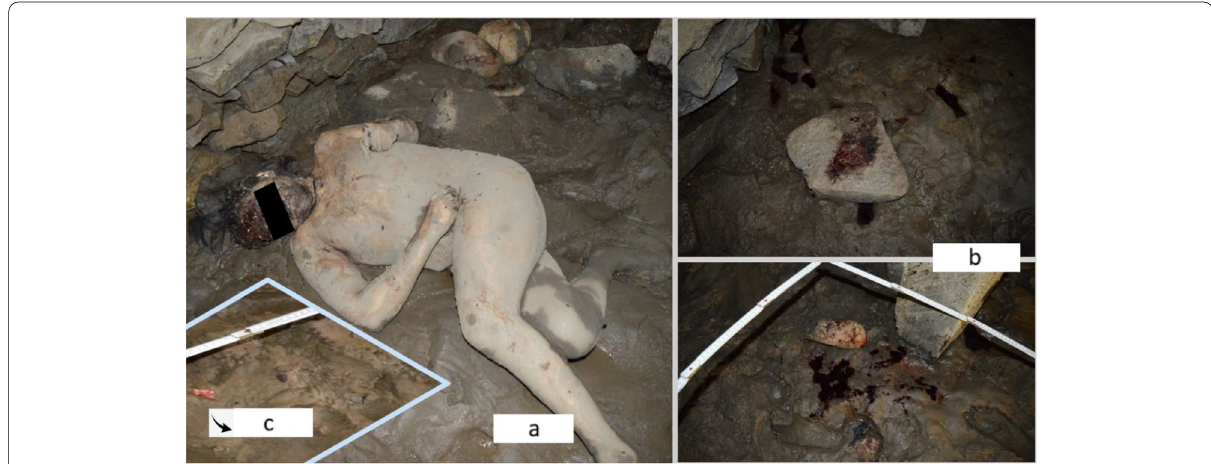
Fig. 1 Details from the on‑site investigation: he was found naked in the basement ( a ); muddy ground with protruding stones ‑ some of them blood‑stained ( b ); a small fragment of the frontal bone ( c